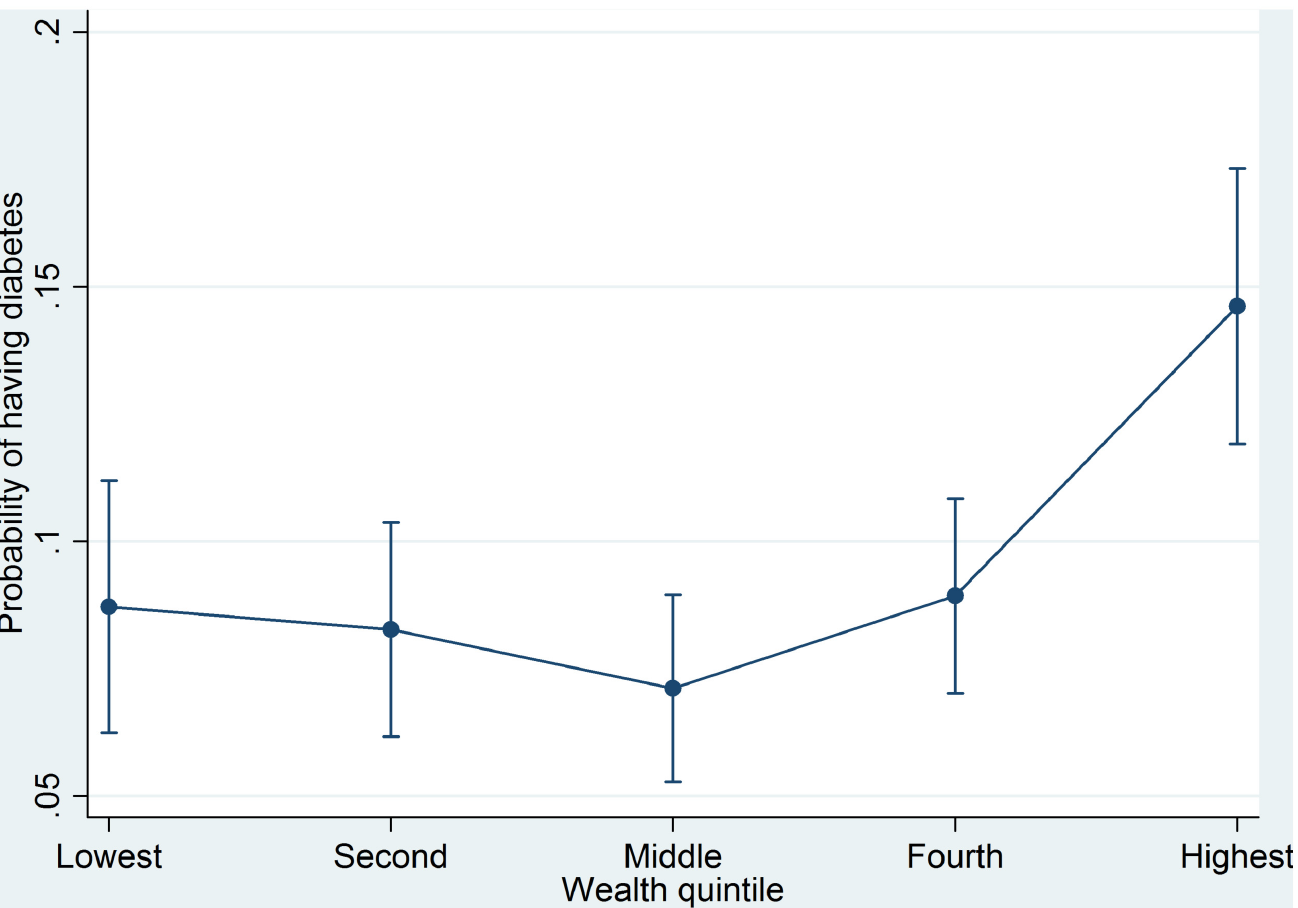
Fig 2. Predicted probabilities of having diabetes by wealth